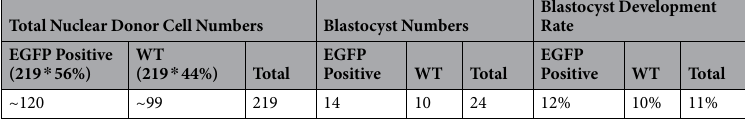
Table 2. The safety evaluation of the gene target